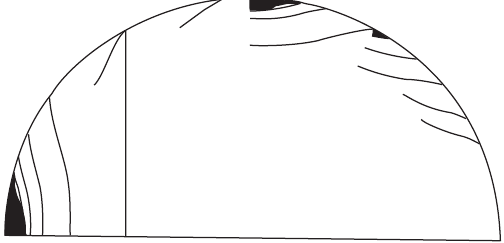
Figure 3.2 . Trinomial arcs B ( n , k , r ) inside the upper half unit